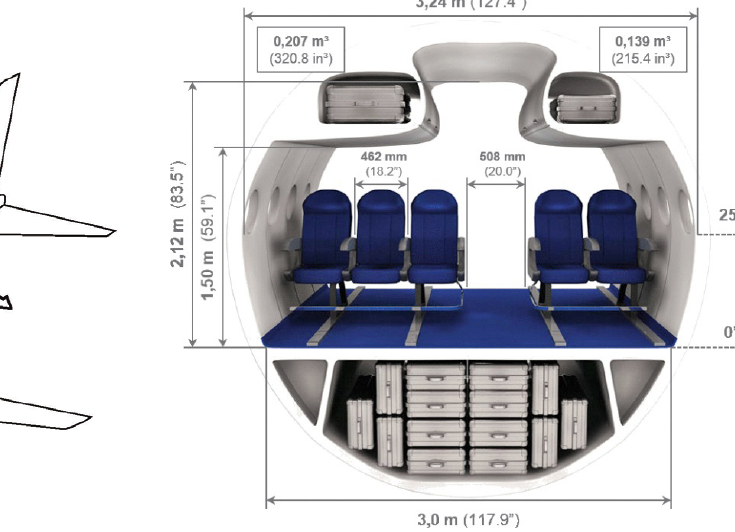
Figure 2. Short-haul passenger airplane of SSJ-100 type Figure 3. Cabin parameters of the aircraft of SSJ-100 type